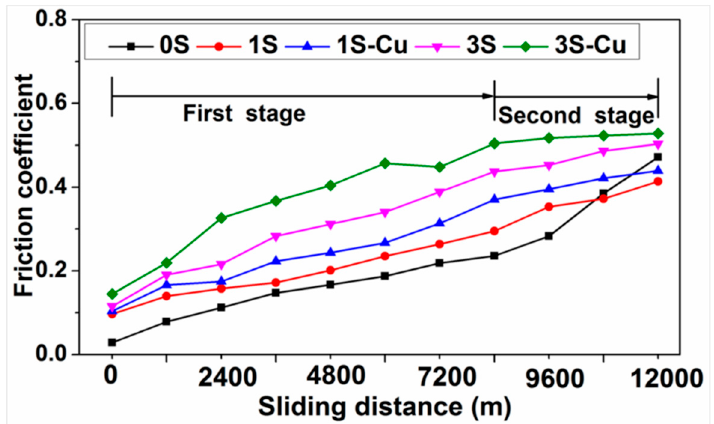
Figure 4. Variation of friction coefficient with sliding distance at applied load of 0.4 MPa and sliding speed of 9 m/s.